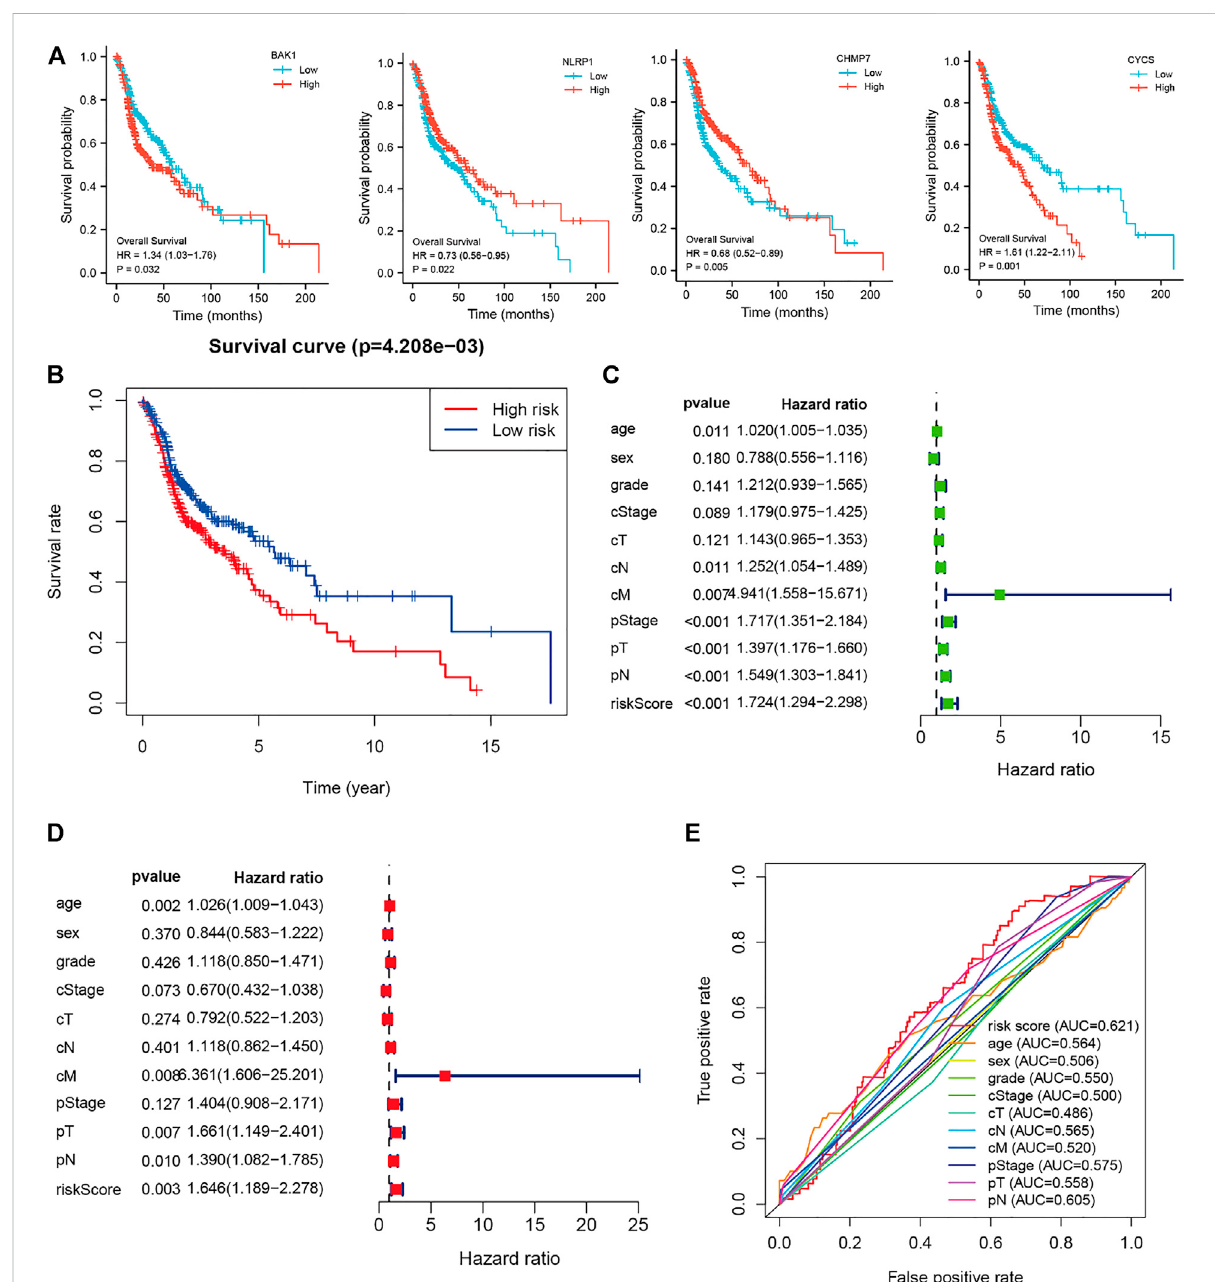
FIGURE 3 Risk and prognostic analysis of the single gene. (A) . Survival analysis to determine the correlation between the expressions of BAK1 , NLRP1 , CHMP7 , and CYCS and head and neck squamous cell carcinoma (HNSCC); (B) . Kaplan-Meier survival curves present the correlation between the prognostic risk scores of patients suffering from HNSCC and thecorresponding overall survival rates; (C – D) . The forest plot shows theunivariate (C) andmultivariate (D) Coxregressionresults;and (E) .Receiveroperatingcharacteristiccurvesarecalculatedfordeterminingriskscoresbasedon the sensitivity and speci fi city of the prognosis of patients with